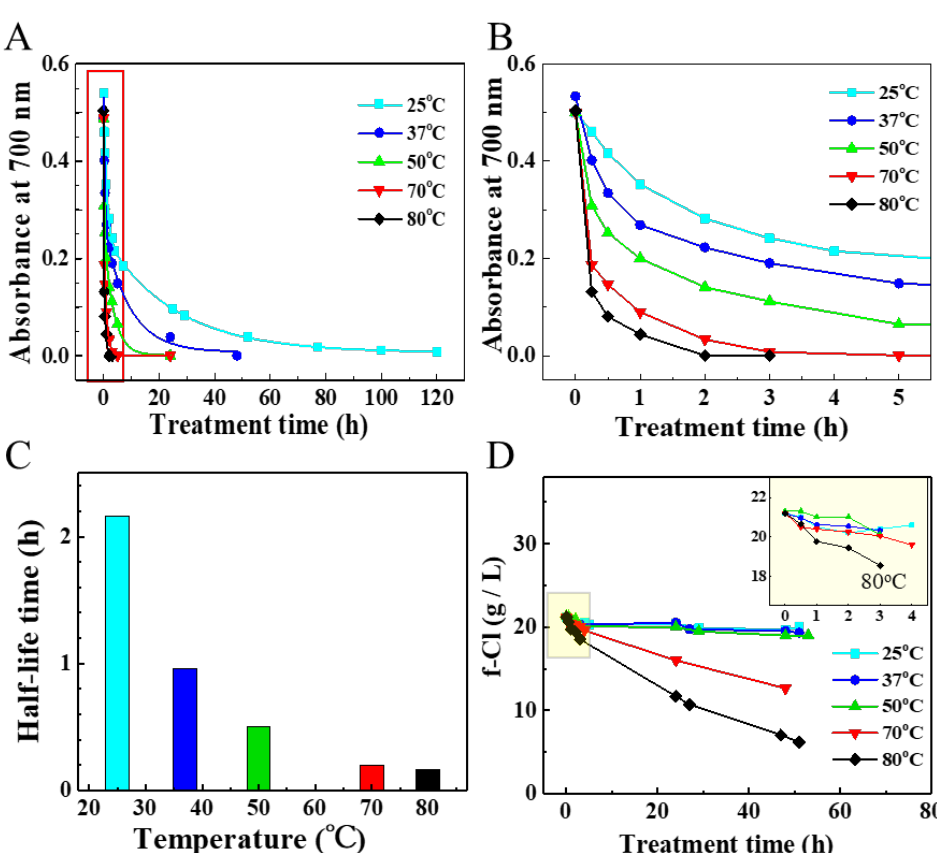
Figure 2. Degradation of SG/BSA with NaClO solution (2.26 wt%) at different temperatures (25 °C, 37 °C, 50 °C, 70 °C, and 80 °C). ( A ) Absorbance of SG/BSA dispersions at 700 nm during treatment, revealing changes in the amount of SG/BSA. ( B ) Close-up view of the red framed part in ( A ). ( C ) Degradation half-life of SG/BSA. ( D ) Changes in the amount of f-Cl in NaClO solution (2.26 wt%) at different treatment temperatures. The inset graph is a close-up view of the yellow framed part. SG/BSA is a CNT-dispersion that was obtained by dispersing SG-CNTs in BSA solution (CNTs: 10 µg/mL; BSA: 0.1 mg/mL).